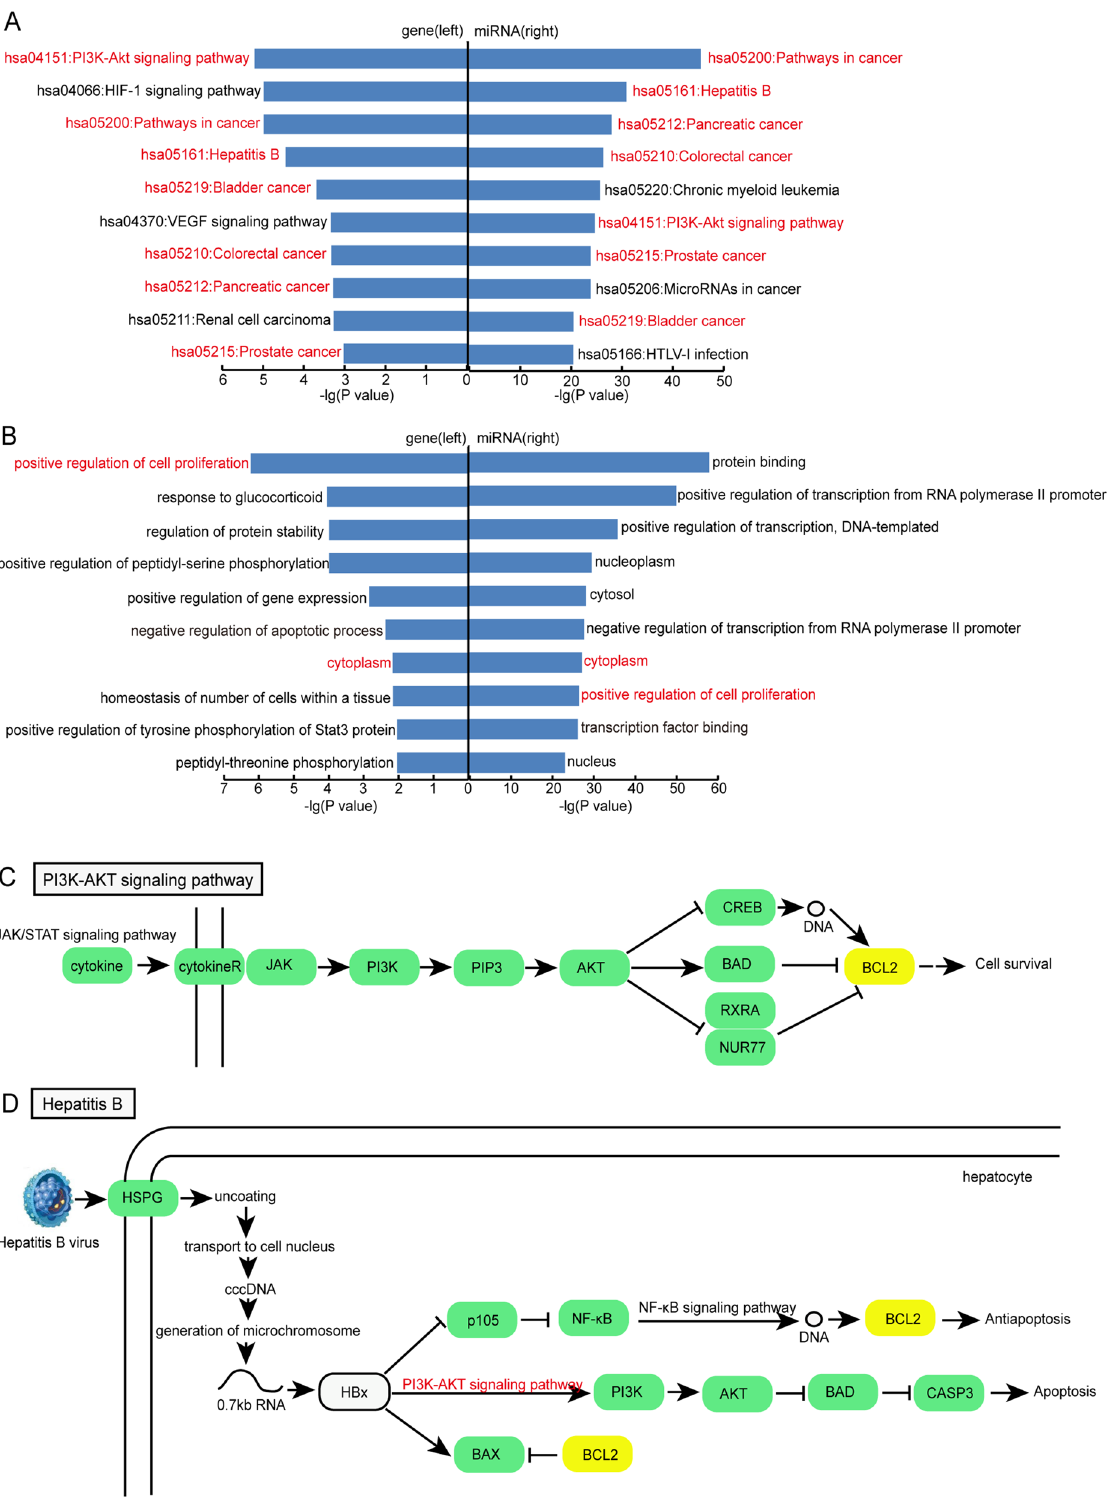
Figure 4. Gene Ontology and KEGG pathway analysis using genes and targets of miRNAs in CFMSN. ( A ) The top 10 pathways enriched by genes (left) and target genes of miRNAs (right). Pathways colored in red are common ones in both left and right. ( B ) The top 10 GO terms enriched by genes (left) and target genes of miRNAs (right). GO terms colored in red are common ones in both left and right. ( C ) A part of PI3K-Akt signaling pathway. ( D ) A part of Hepatitis B pathway. Genes with a yellow background is the risk genes from CFMSN. GO: Gene Ontology; KEGG: Kyoto Encyclopedia of Genes and Genomes; CFMSN: 3/4/5-node composite FFL motif-specific